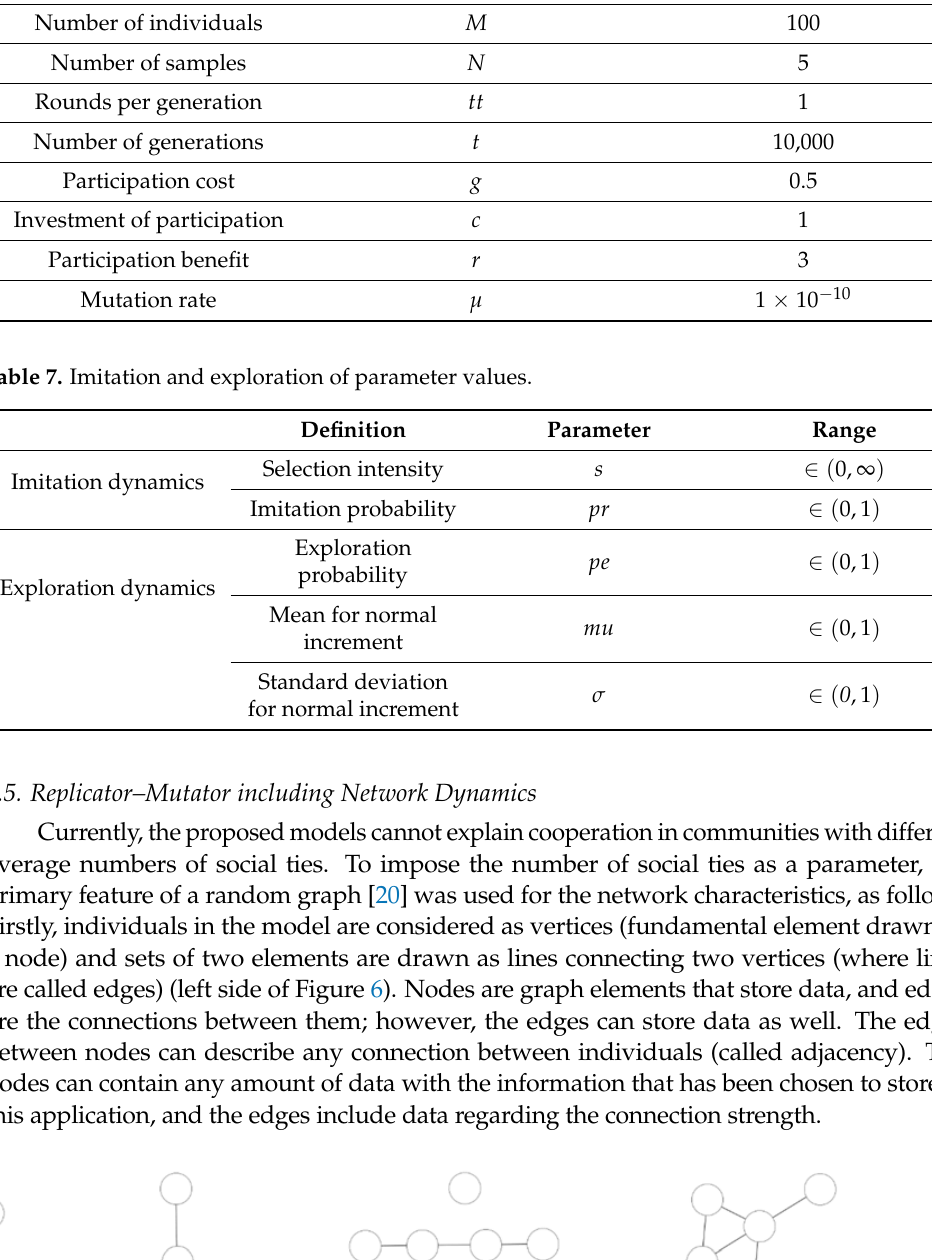
Figure 7. Schematic representations of edge ( left side ) and adjacency ( right side ) lists. ( a ) Edge list (2D), ((0, 1), (1, 2), (1, 3), (2, 3)); ( b ) Adjacency list (2D), 0 = (0, 1), 1 = (1, 2), 2 = (1, 3), 3 = (2, 3). In this array, each space is used to store a list of nodes, such that the node with a given ID is adjacent to the index with the same number. For instance, an opening at index 0 represents a vertex with an ID of 0. This vertex shares an edge with one node, so that the reference to that node is stored in the first spot in the array. Thus, because the list contains other lists, the adjacency list is two-dimensional, enabling an adjacency matrix to be used that is essentially a two-dimensional array; however, all lists within it have the same length. 2.6. Social Ties from Eigen Centrality Algorithm Owing to the collection of nodes influenced by connection probabilities correspond- ing to the adjacency list, the distribution of the connections in the network can be used for the social characteristics (probability of degree) as follows ∑